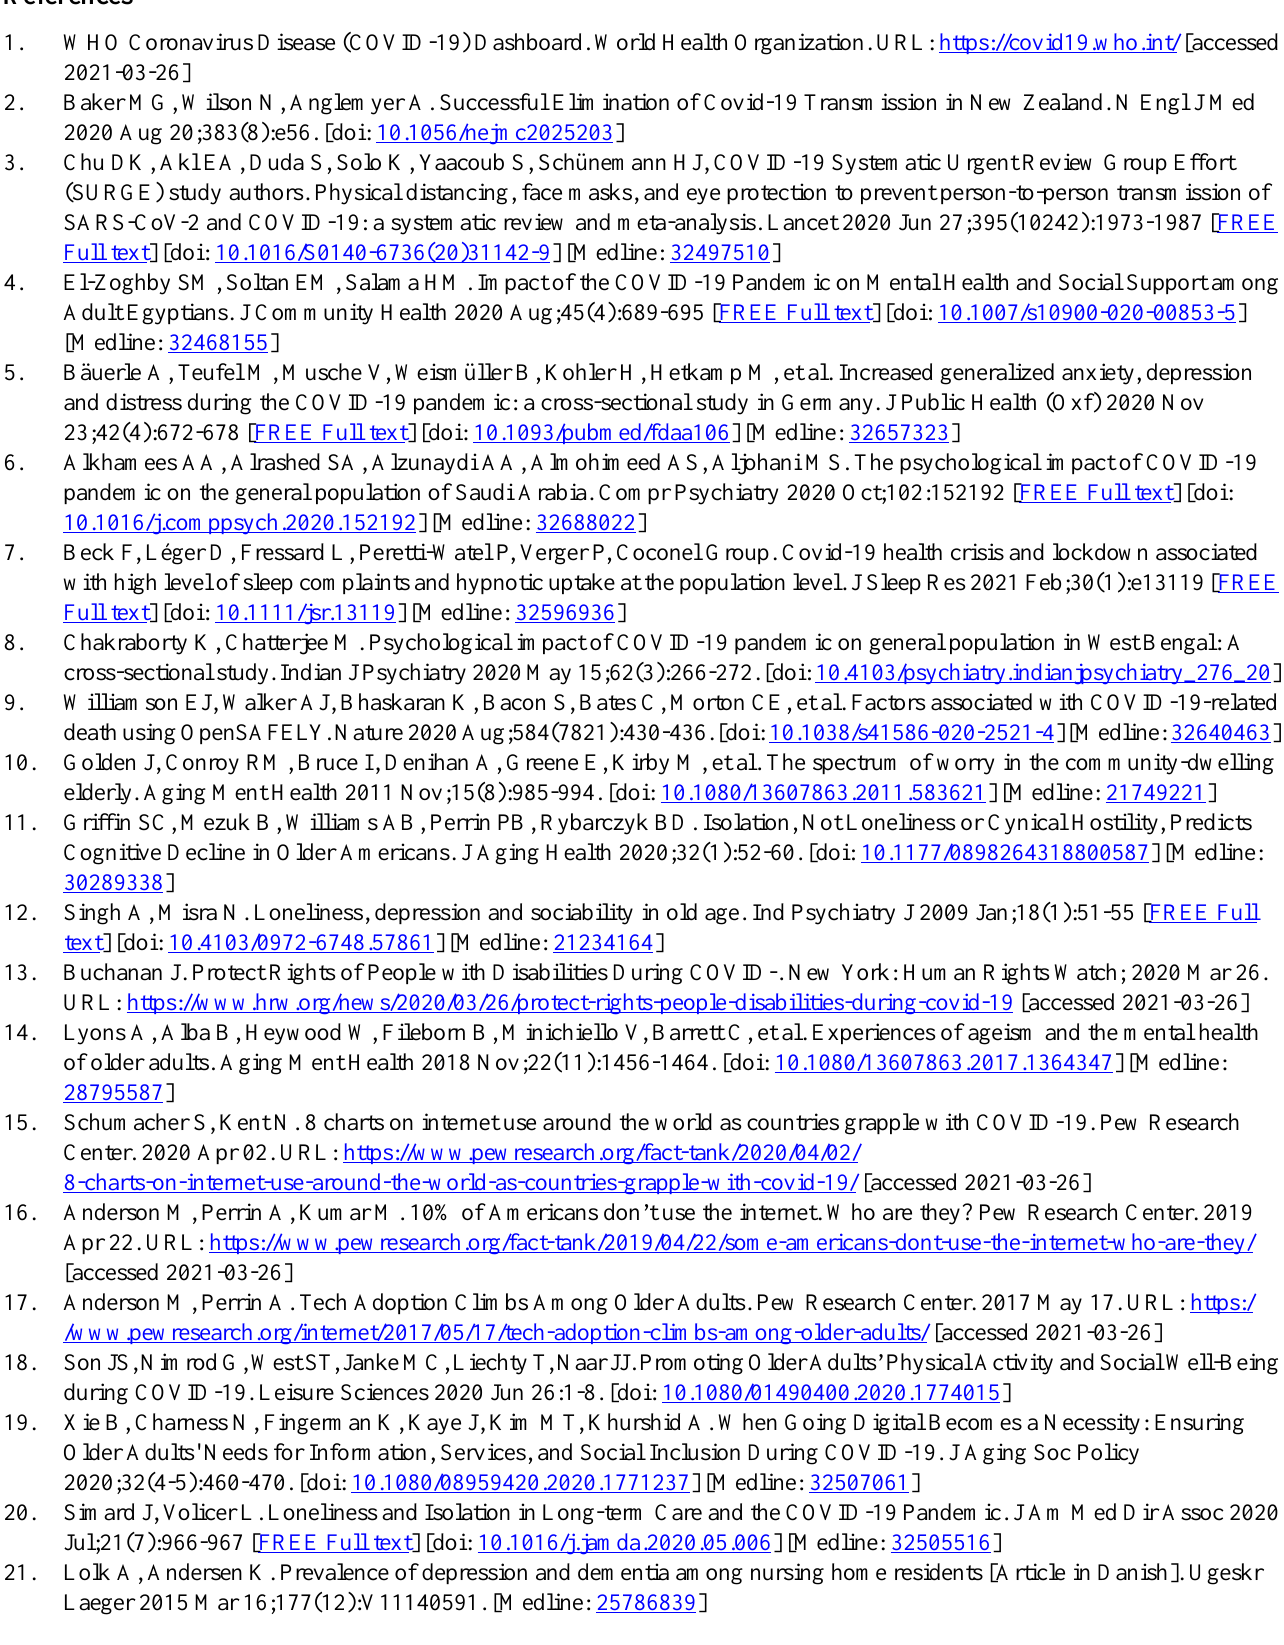
Table S1. Synthesis of the 135 selected studies and their level of